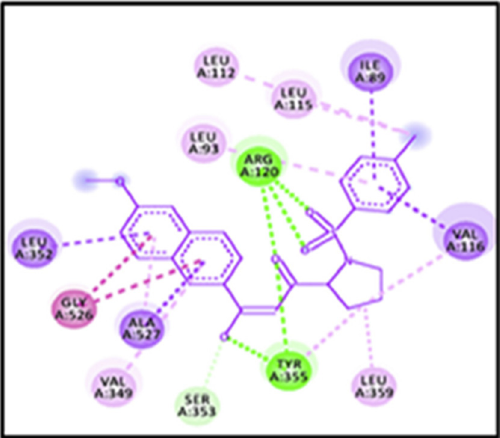
Figure 14. Structure of 1-(6-methoxy-2-naphthalene-2-yl)-3-(tosylpyrrolidine-)2-yl) propane-1,3-dione docked to cyclooxygenase (COX-1). Taken from Ref. [90] with permission from Elsevier.